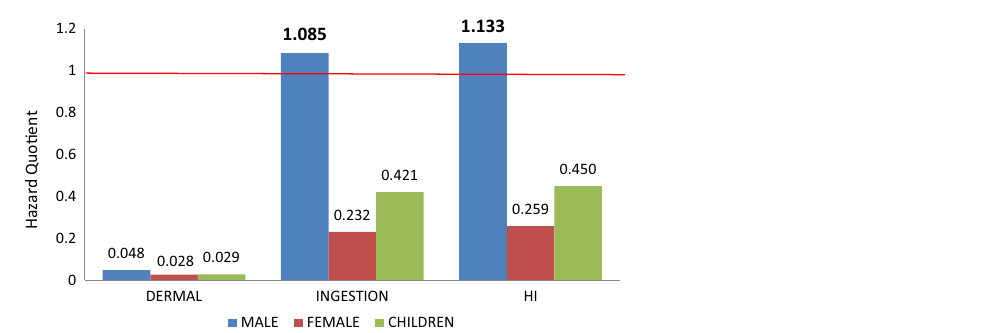
Figure 5. Total hazard quotients for dermal, ingestion and combined routes in males, females, and children. Emboldened and enlarged figures with a bar above the red line (> 1) represent significant hazard